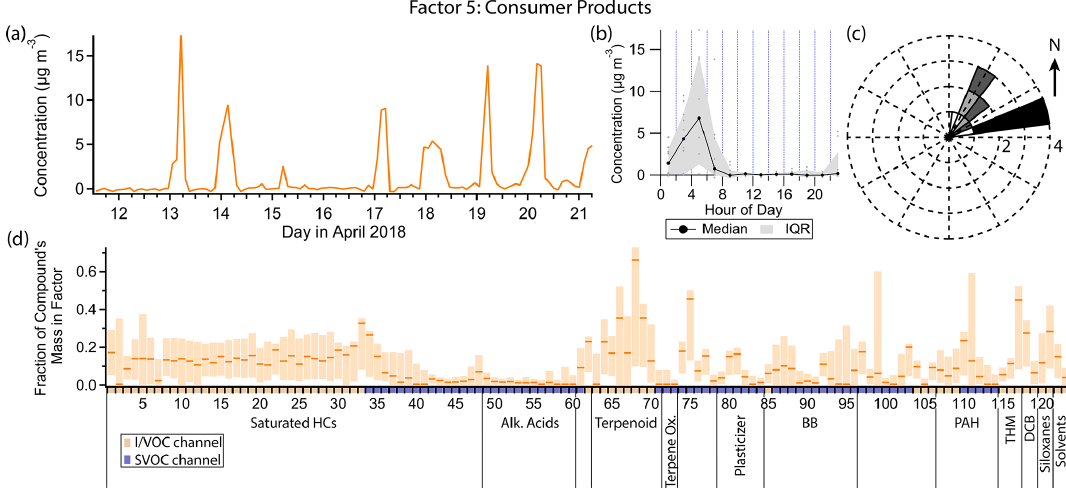
Figure 10. (a) Factor 5 timeline. (b) Diurnal profile for Factor 5. (c) Rose plot showing correlation of elevated emissions and wind direction. (d) Factor 5 composition profile. See Fig. 4 description for further information on how to read this figure.